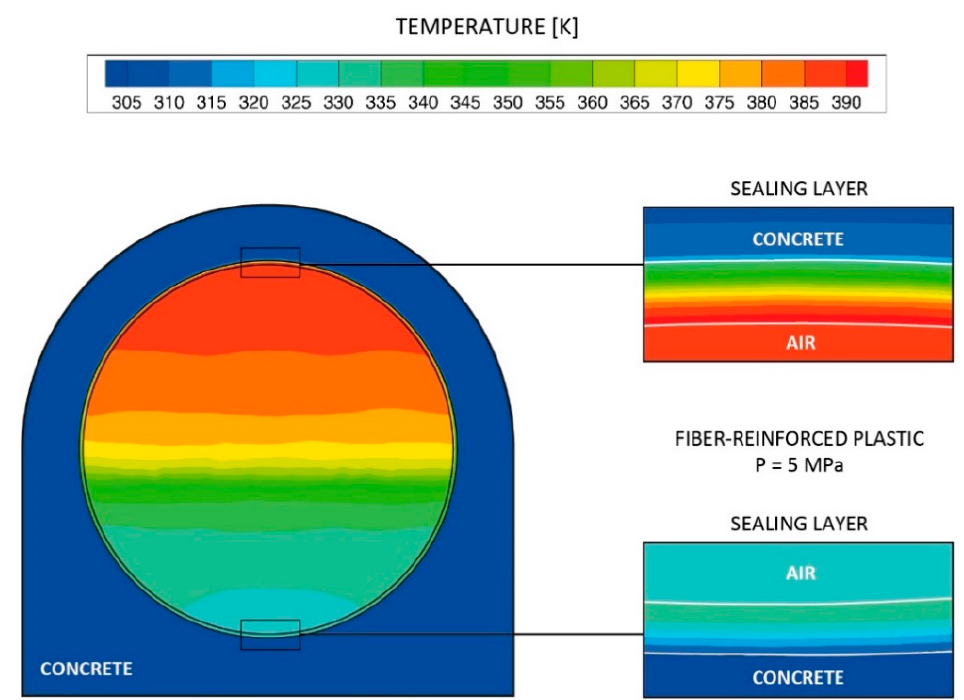
Figure 11. Numerical model results in the first cycle at 5 MPa (decompression). Distribution of air temperature within the reservoir and temperature detail in the FRP and concrete.